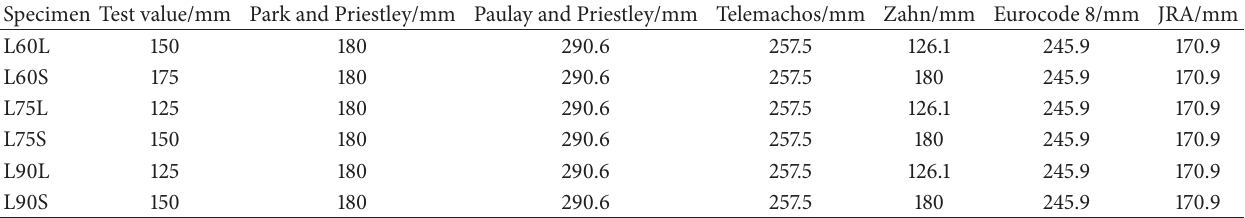
Table 4: Comparison between test values and calculated values of length of plastic hinge.